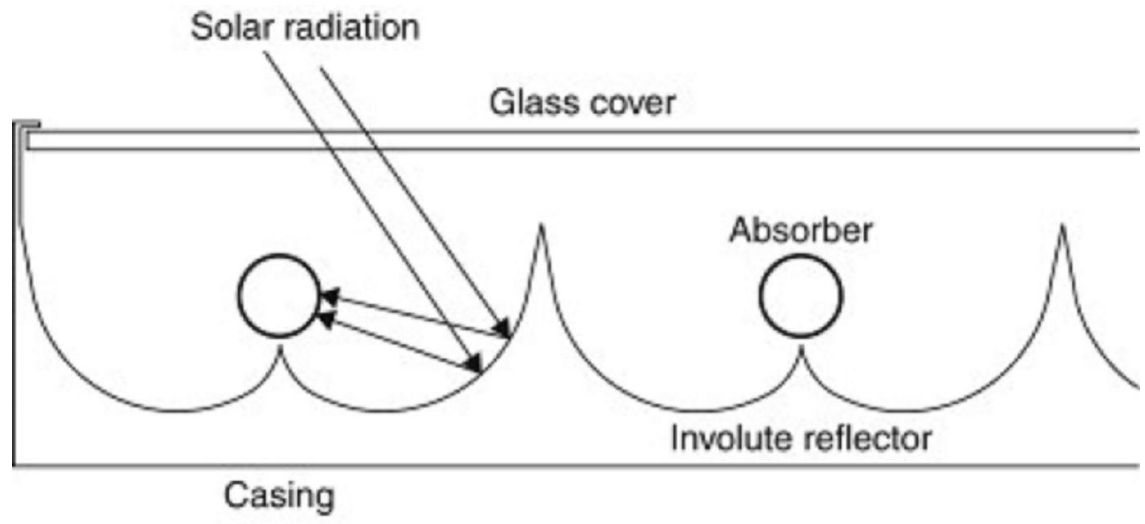
Figure 7. Compound parabolic collectors [53].